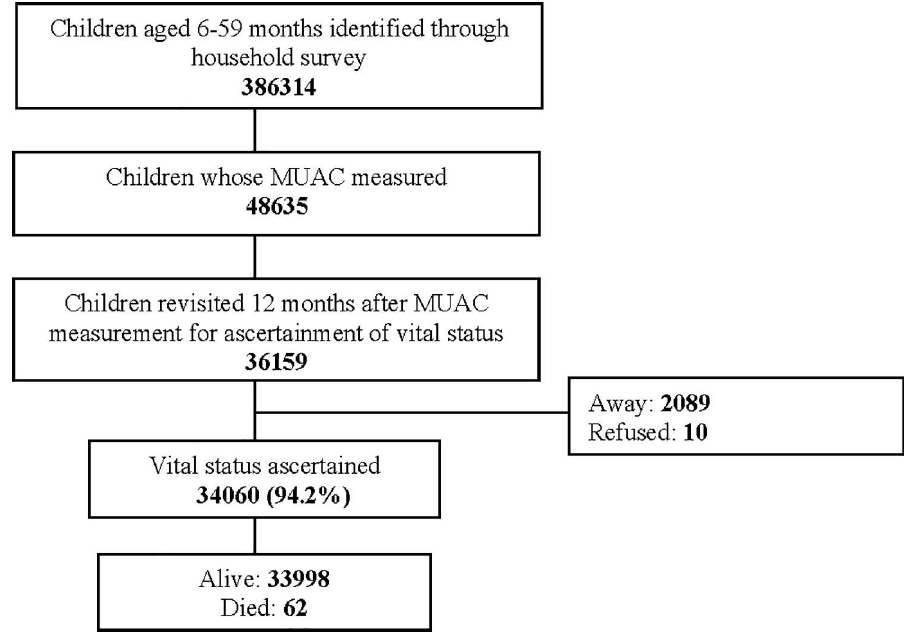
Fig 1. Trial profile.